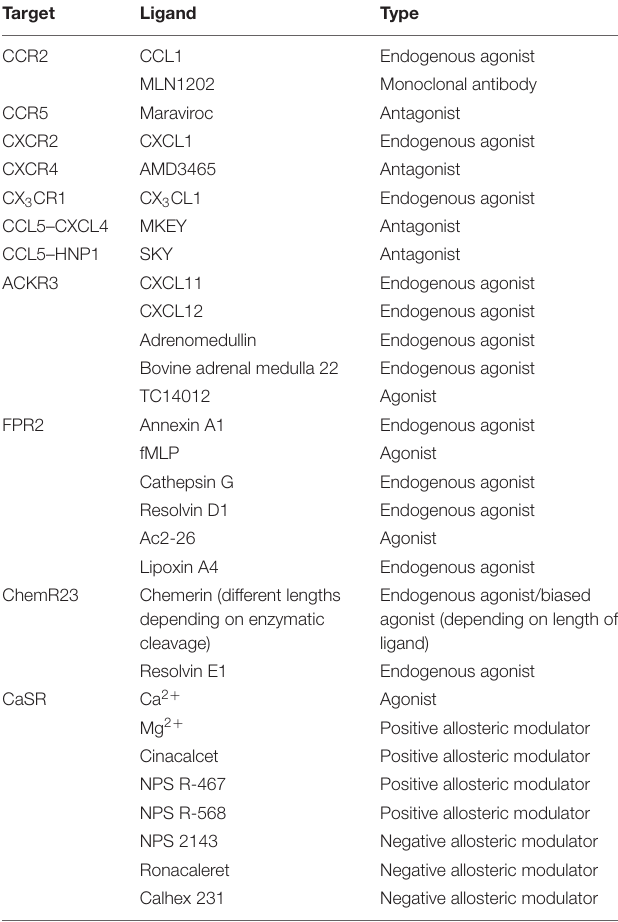
TABLE 2 | Types of GPCR-ligands discussed in the